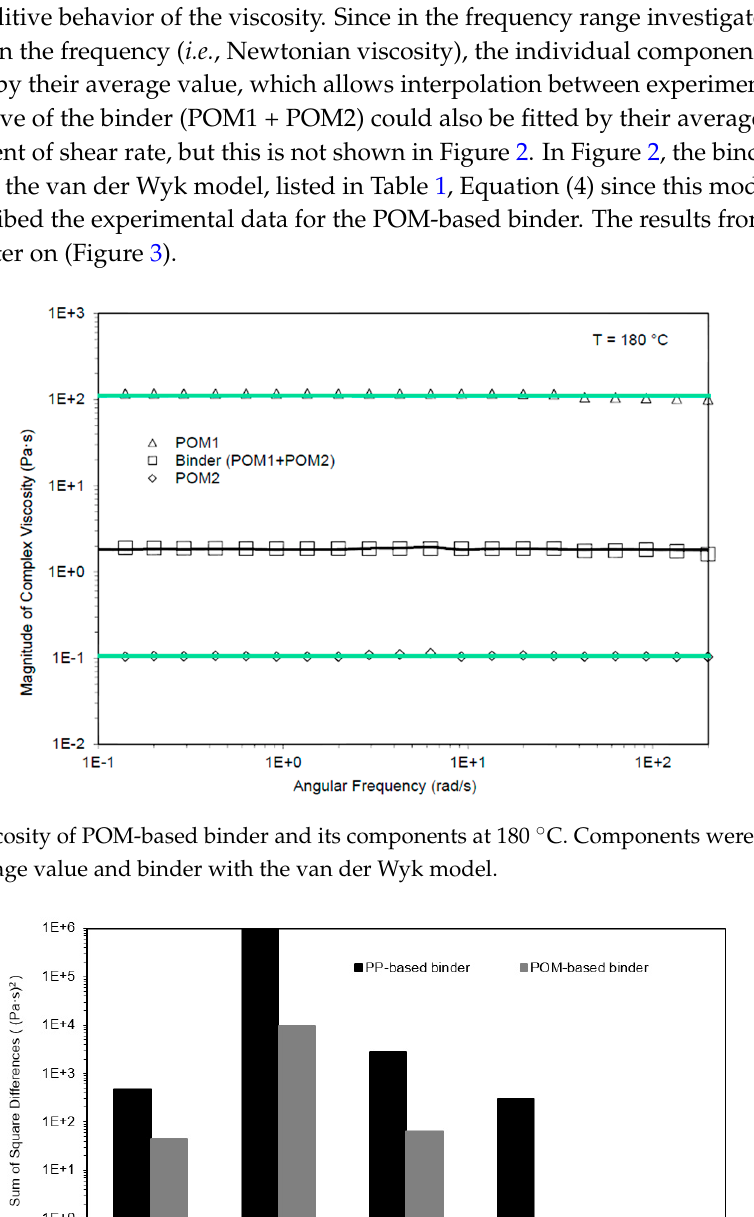
9 of 17 Figure 1. Viscosity of PP ‐ based binder and its components at 170 °C [41]. Components were fitted (line) by the Carreau model and binder with the Grunberg ‐ Nissan model. © Christian Kukla (Montanuniversitaet Leoben). Figure first published by EPMA in the Euro PM2014 Proceedings. The binder’s viscosities were fitted by 5 distinct mixing rules in order to find the most applicable to our multicomponent binder systems. The models investigated here included the ones proposed by Arrhenius [8]; Voigt [9]; van der Wyk [11]; and Grunberg and Nissan [12]. All the fittings were performed using the nonlinear generalized reduced gradient algorithm [18] implemented in Excel Solver by minimizing the sum of square differences between the measured viscosity and the calculated viscosity (Equation (23)).